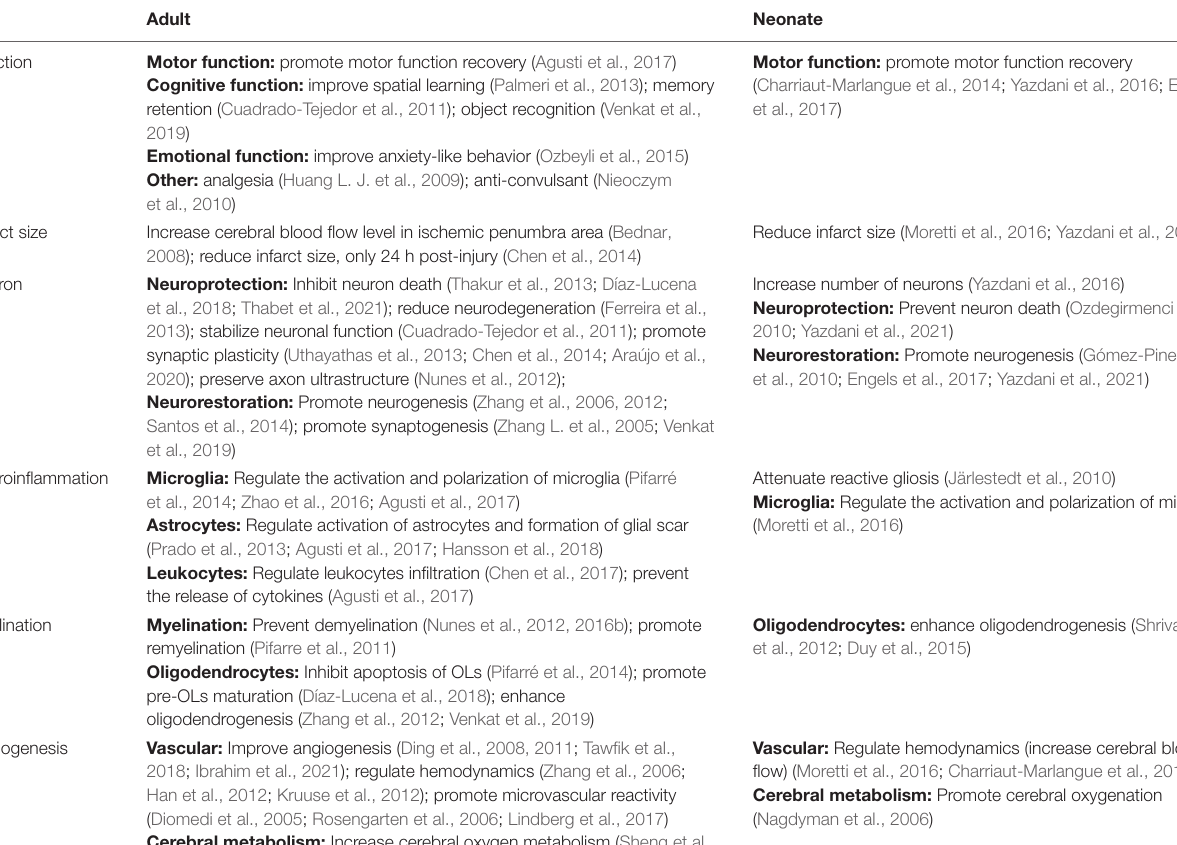
TABLE 1 | The role of sildenafil in adult and neonatal brain injury. Adult Neonate